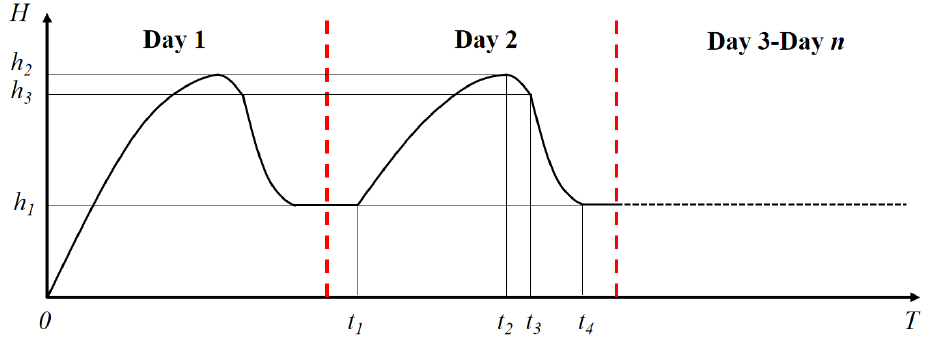
Figure 16. Typical flight profile.